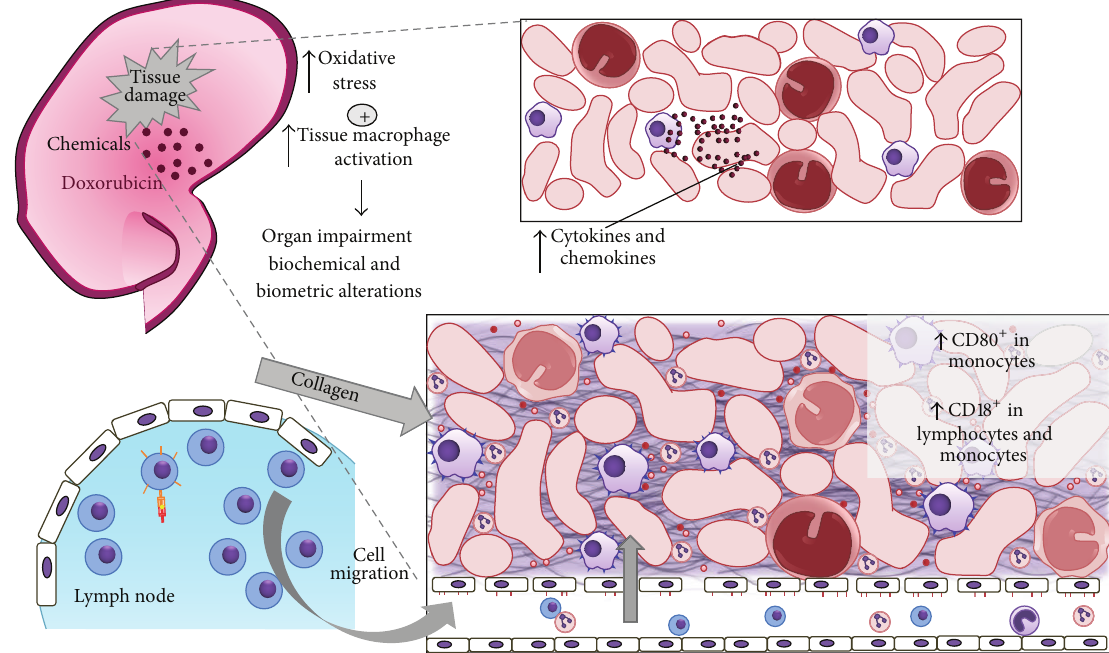
Figure 4: Schematic figure of proposed pathogenesis of kidney damage in doxorubicin-induced nephropathy. Doxorubicin induced chemical kidney damage, which activated tissue macrophages and increased local oxidative stress. This situation caused organ impairment and biochemical alterations. Activated macrophages released cytokines and chemokines, which activated and recruited new cells, especially monocytes and lymphocytes from lymph nodes. These cells accumulated in the kidneys, inducing collagen accumulation and, consequently, worsened kidney